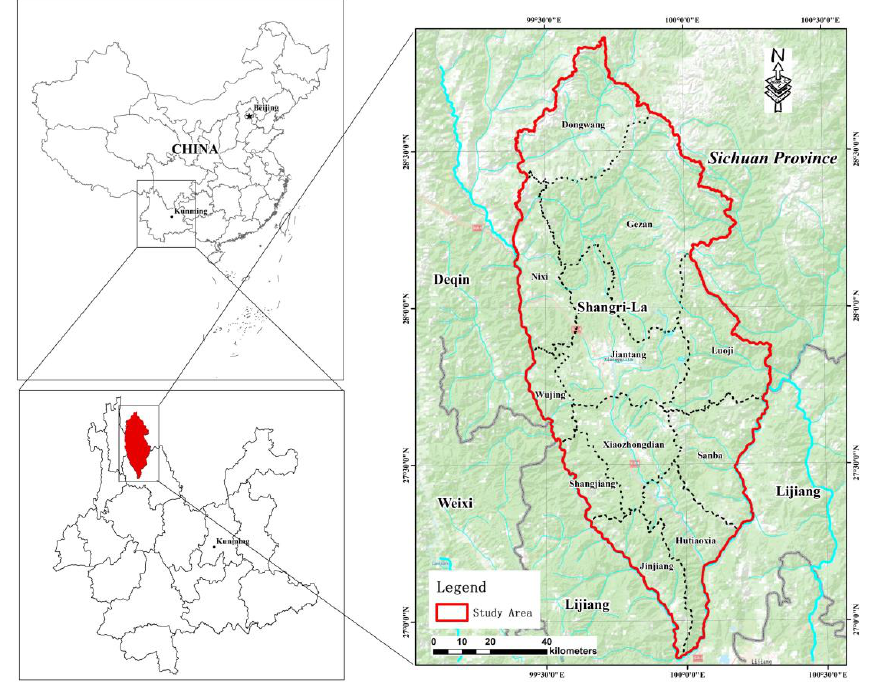
Figure 1. Study Area.